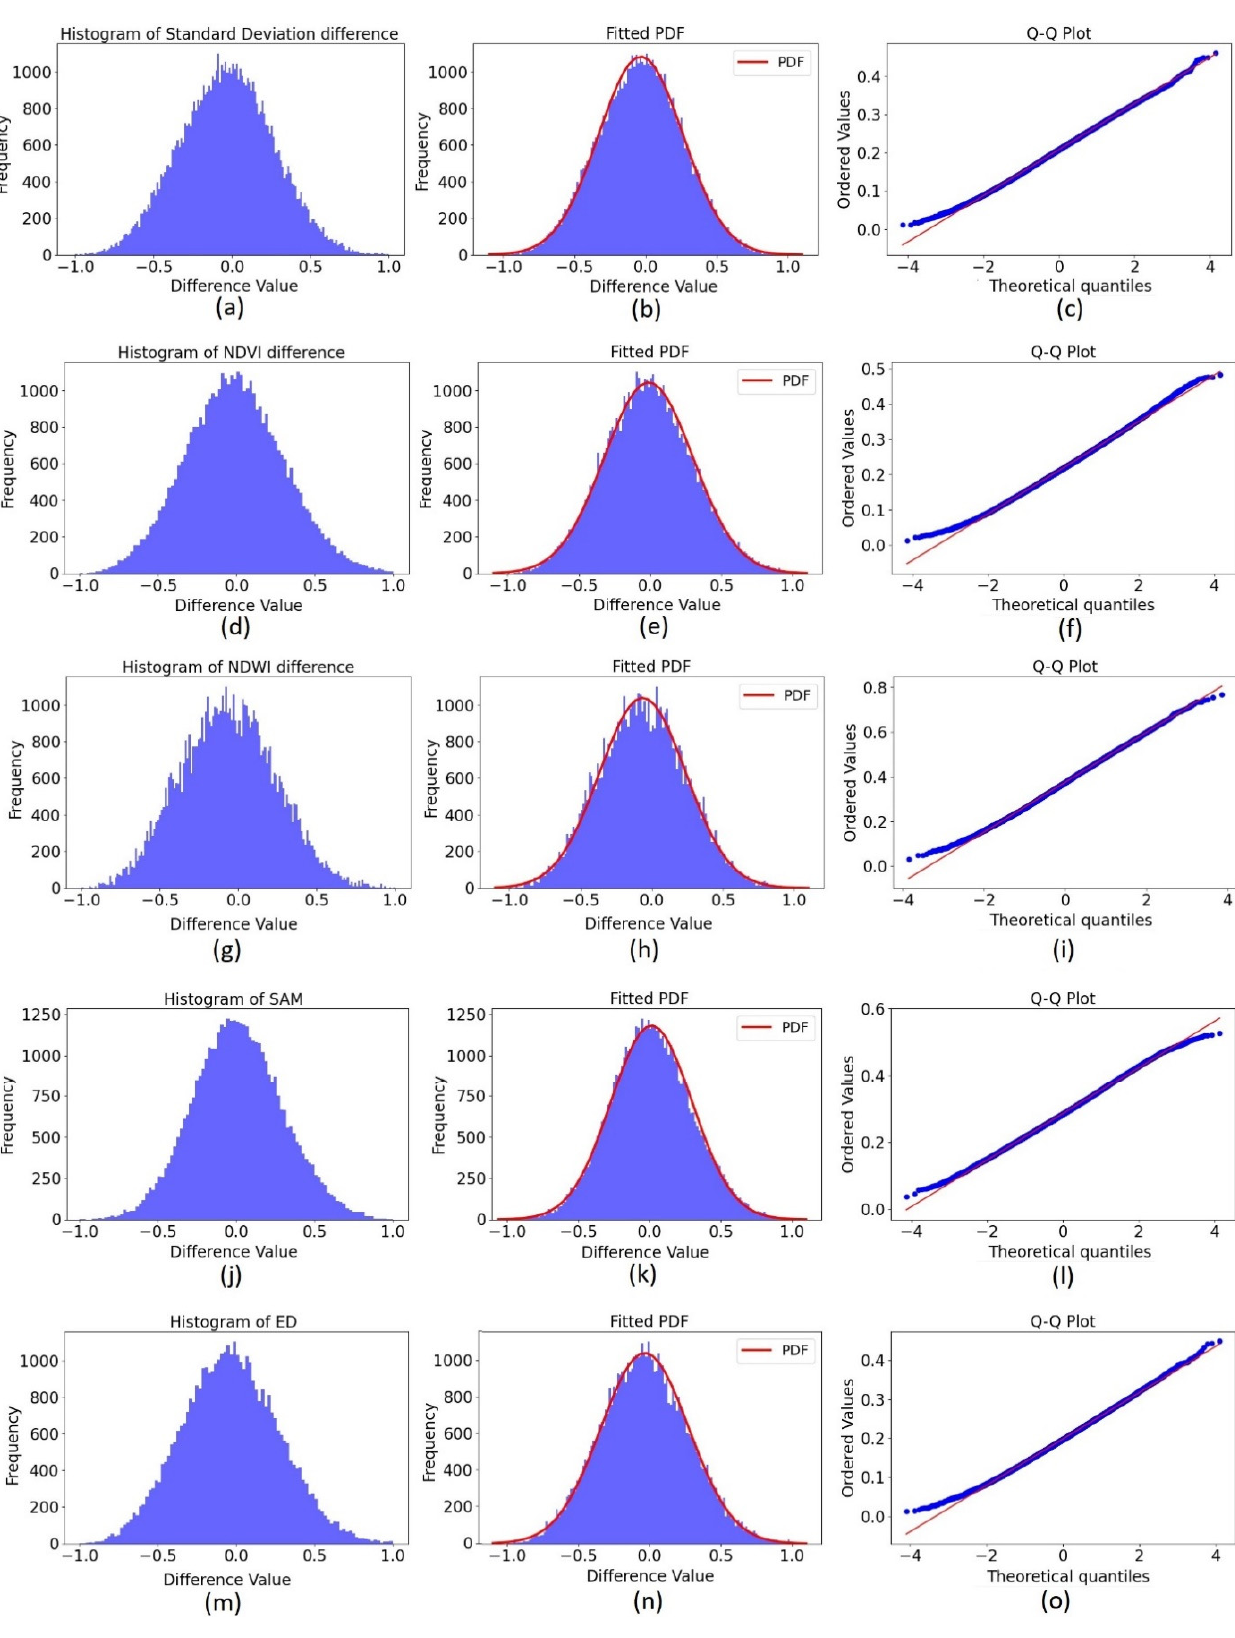
Figure A2. Normality test procedure for 2018’s change images. ( a , d , g , j , m ) The histogram of the change images. ( b , e , h , k , n ) The fitted PDF. ( c , f , i , l , o ) The Q-Q plot of the change images.